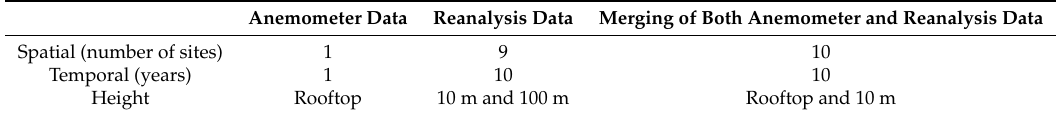
Table 1. Summary of the scope of each data